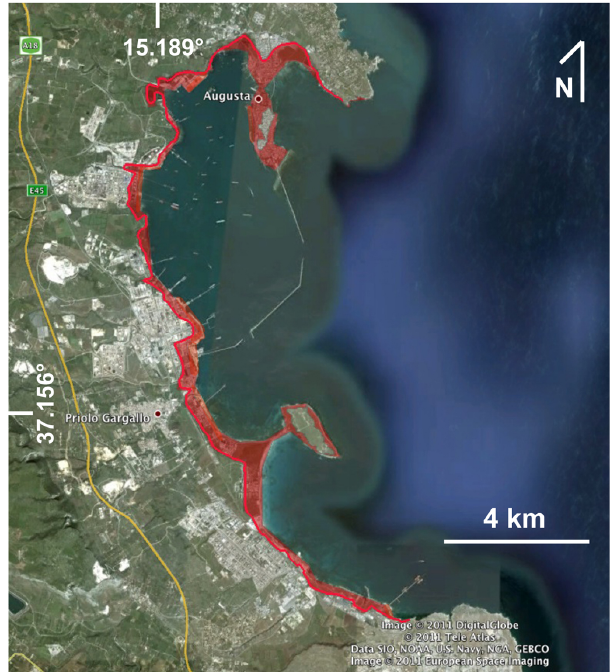
Fig. 5. Map of the coastal area potentially inundated by future large tsunamis (in red) in the Augusta Bay (background from Google Earth). This figure was obtained assuming that the geological observations from paleotsunamis are representative of the worst effects of tsunamis in this area, and thus their inundations may extend up to 500 m inland and